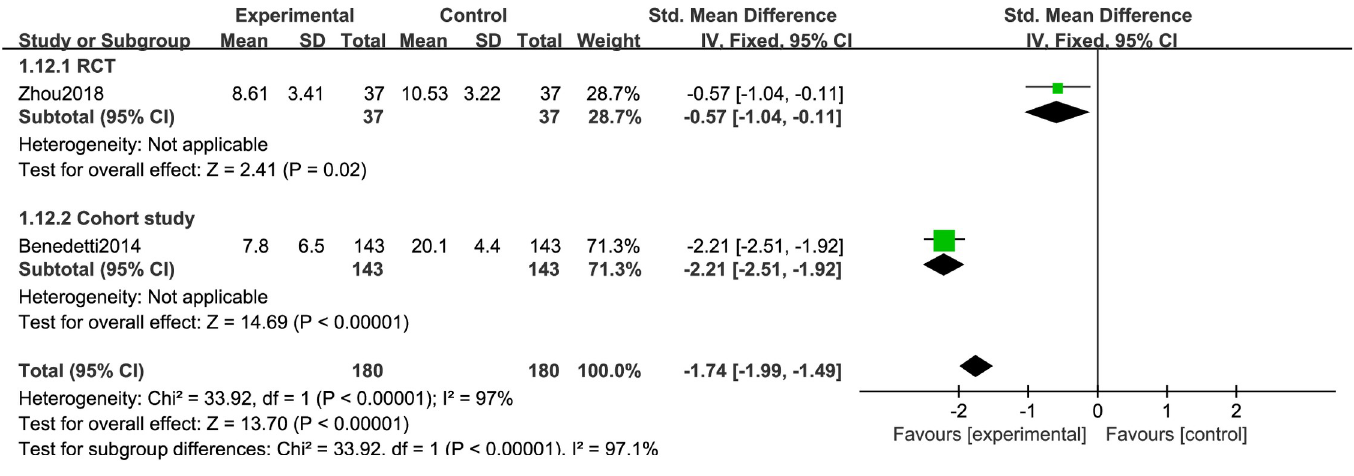
Fig 10. Forest plots with a color temperature less than 4500k.